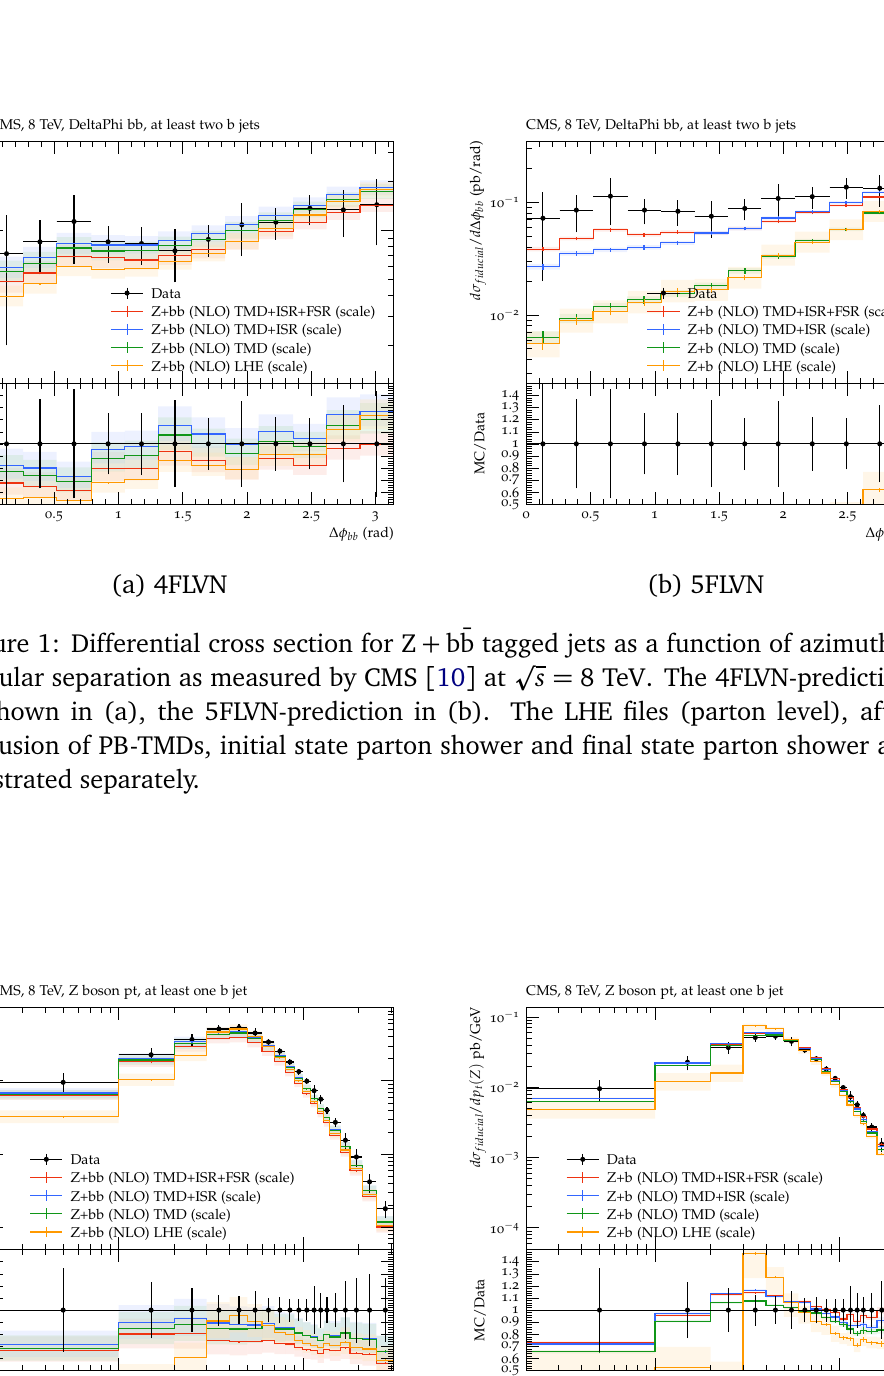
(cid:112) s = 8 TeV. The 4FLVN-